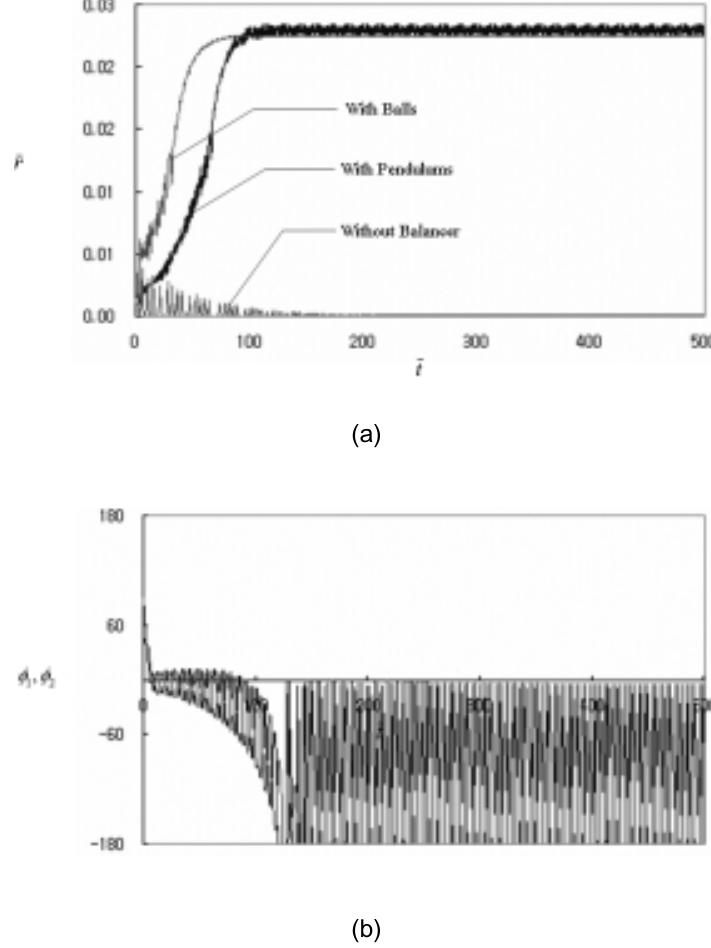
Fig. 10. Time response of system with Pendulum or Ball Automatic Dynamic Balancer for ˜ ω = 0 . 9 and ˜ m = 0 . 116 . (a) Time response of the radial displacement. (b) Time response of the pendulum